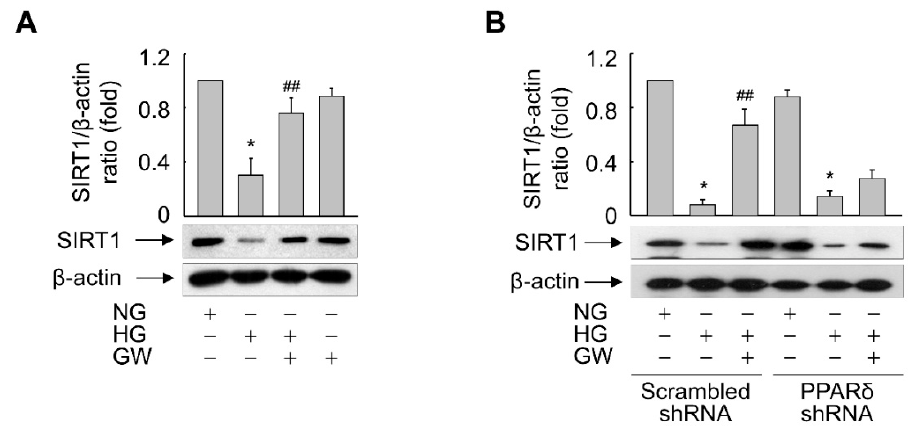
Figure 8. Ligand-activated PPAR δ reverses the HG-triggered suppression of SIRT1 expression in ARPE-19 cells. ( A ) Cells pretreated with 100 nM GW501516 (GW) for 24 h were exposed to NG (5.6 mM) or HG (30 mM). ( B ) Cells stably expressing scrambled or PPAR δ -targeting shRNA were pretreated with 100 nM GW501516 (GW) for 24 h and then exposed to NG or HG. After incubation for 48 h, whole-cell lysates were prepared and subjected to Western blot analyses. An image analyzer was used to quantify the band intensities, and the ratio of SIRT1 to β -actin was determined. Representative blots from three independent experiments are shown and quantitative data are shown as means ± S.E. ( n = 3). * p < 0.01 compared with the NG-treated group. ## p < 0.05 compared with the HG-treated